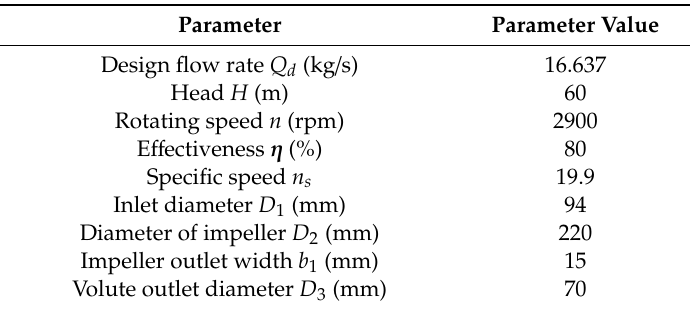
Table 1. Main design parameters of centrifugal